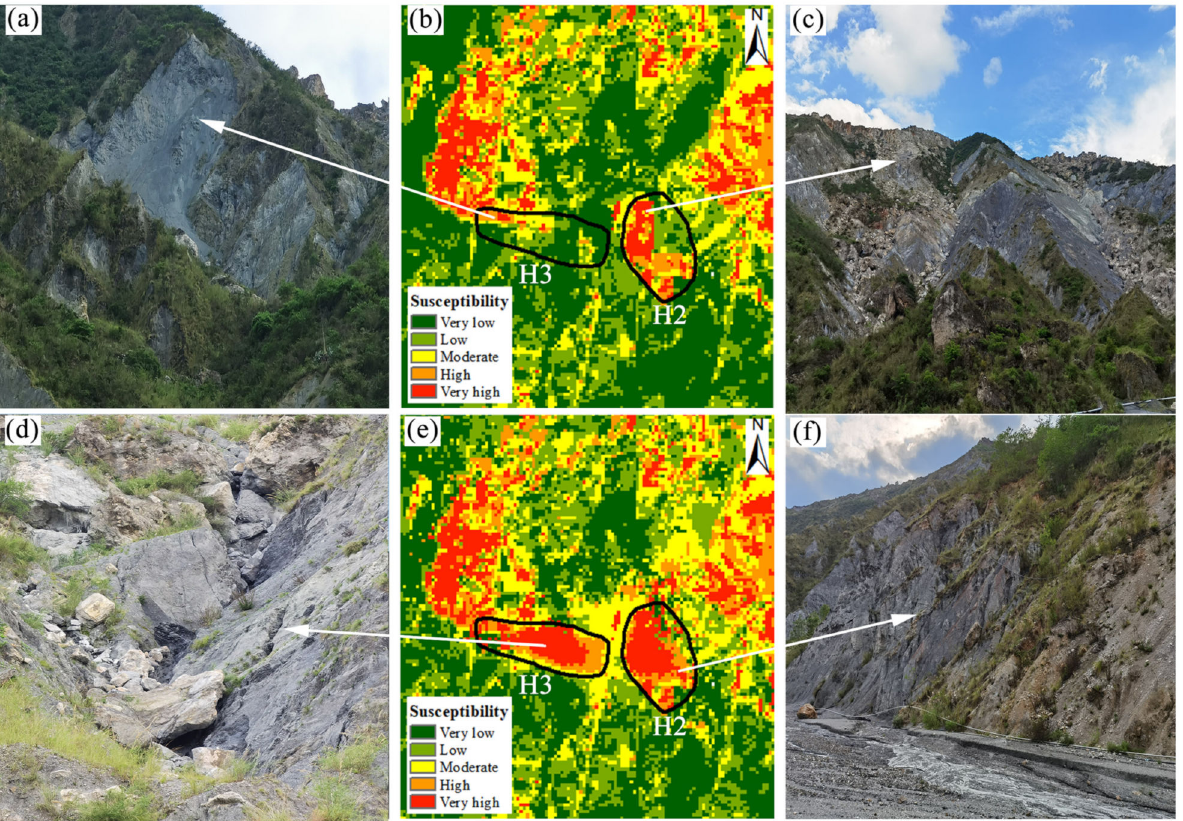
Figure 8. Fieldwork and susceptibility maps before and after correction of typical areas. ( c , f ) are field maps of the H2 region, ( a , d ) are field maps of the H3 region, ( b ) is the pre-correction susceptibility map, and ( e ) is the post-correction susceptibility